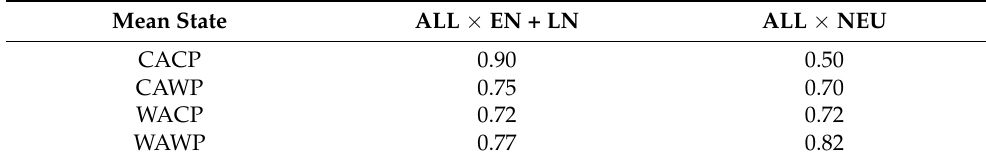
Table 5. Austral summer pattern correlations for PRP between ALL and EN + LN composites and between ALL and NEU composites in each mean